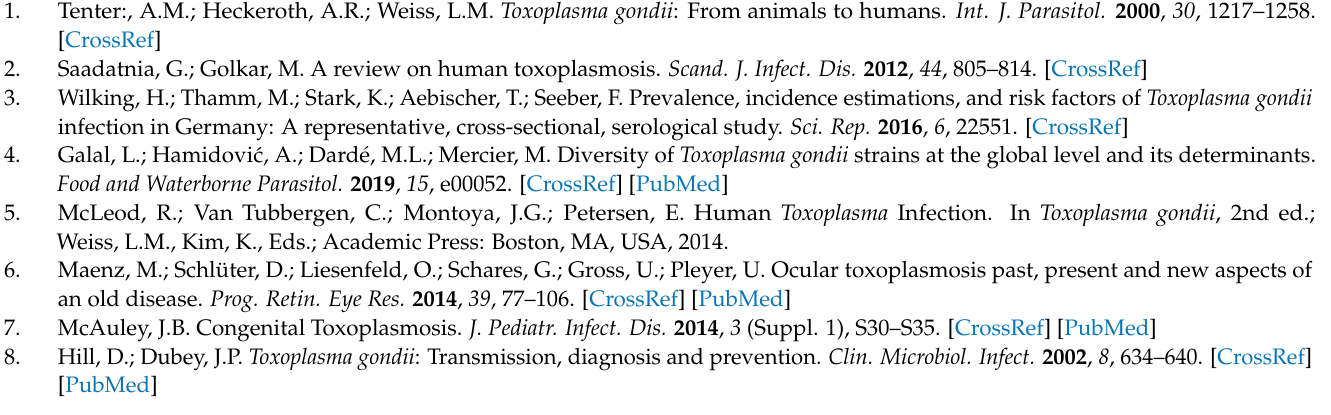
Table S5: Cq-values and corresponding dilution of positively tested heart samples of individuals investigated by three direct detection methods. Table S6: Overview of result combinations observed among individuals that tested positive in at least one direct detection method. Table S7: Concordance between DE qPCR, PD qPCR, MC qPCR and ELISA measured in kappa-values ( κ (95% CI)) among individuals analysed by all three